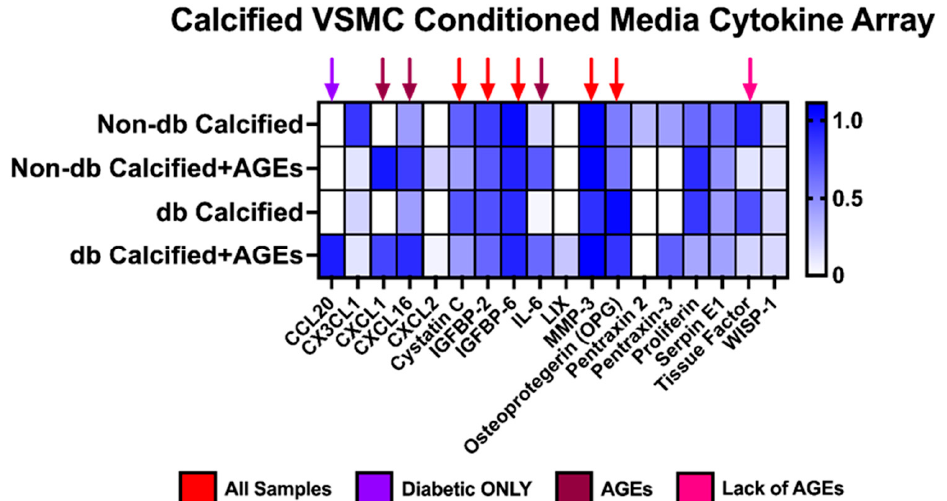
Figure 10. Calcified VSMCs-conditioned media from non-diabetic and diabetic cells released different cytokines, chemokines, and proteins. Pooled calcified VSMCs-conditioned media ( n = 3–4) was utilized for a cytokine array kit and manufactured instructions were followed. Densiometric analysis was used for each spot and normalized to the average of the reference spots for each membrane. No statistical analysis was performed.